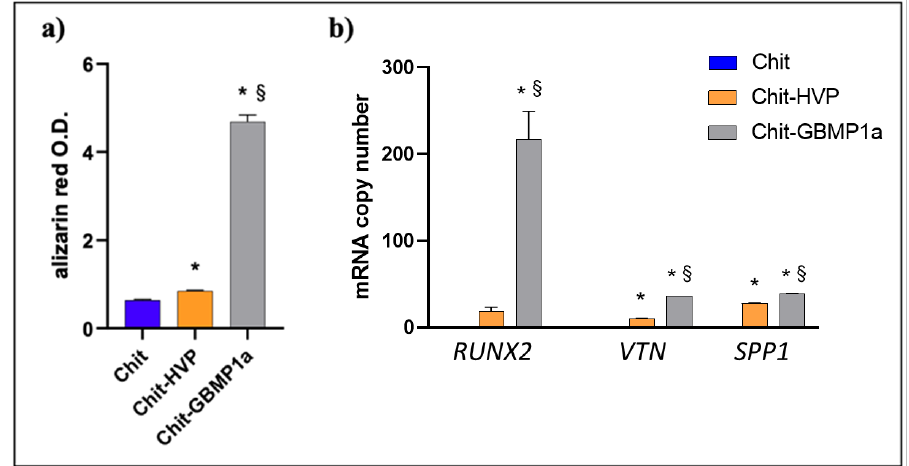
Figure 6. Calcium salt deposition and gene expression assays. ( a ) Levels of calcium were evaluated in osteoblasts cultured for 7 days in differently functionalized chitosan matrices. O.D.: optical density. ( b ) Human Runx2 Vtn and Spp1 mRNA-specific transcript levels were evaluated by quantitative RT-PCR on cells cultured on Chit, Chit-HVP, and Chit-GBMP1a for 24 hr. * p -value < 0.05 vs. Chit; § p -value < 0.05 vs. Chit-HVP.